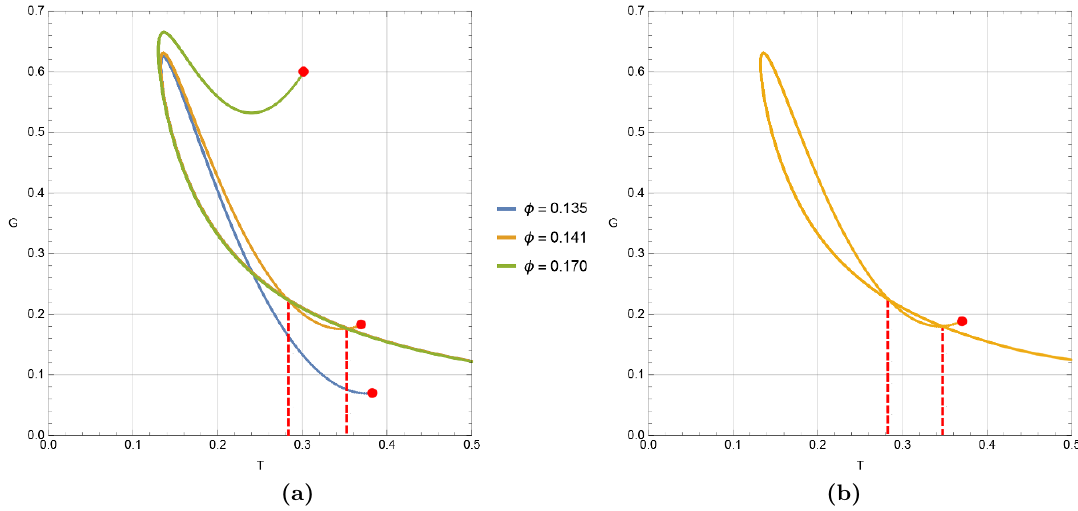
Figure 8 . Free energy at (cid:12)xed potential, with r c = 1 : 5, (cid:3) = 0 : 001. The temperatures at which phase transitions occur are indicated by the red dashed lines. The cavity radius r c is indicated by a red dot. Left : the Reissner-Nordstrom-de Sitter black hole, with varying (cid:30) . Right : the Born-Infeld-de Sitter black hole with b = 10 for (cid:30) = 0 :